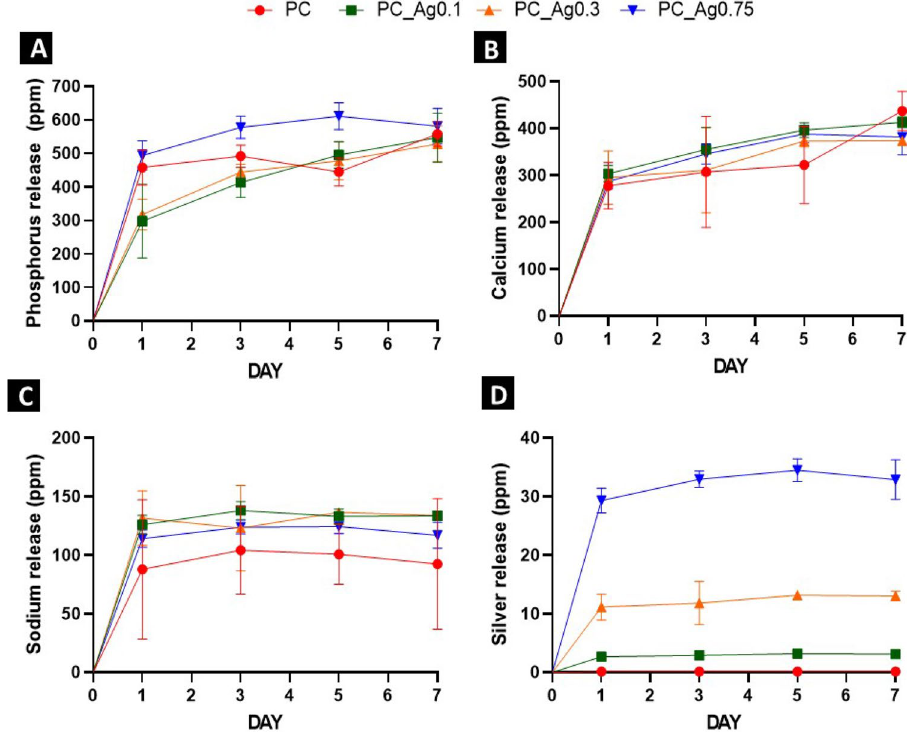
Figure 2. Ion release of ( A ) phosphorus, ( B ) calcium, ( C ) sodium and ( D ) silver in deionized water over 7 days for all PC gels. Error bars indicate the mean ± standard deviation (n = 3).